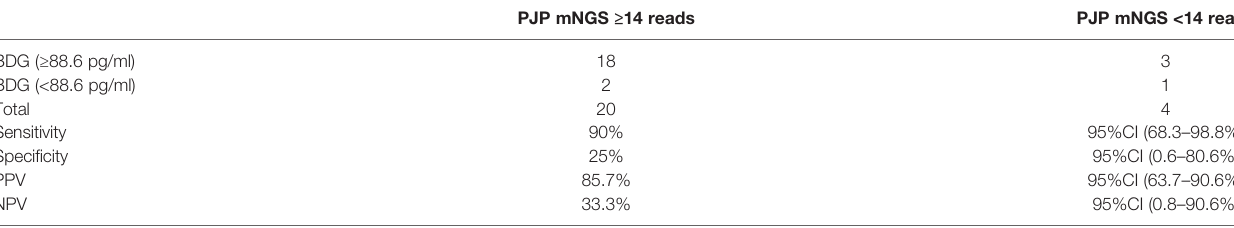
PJP mNGS ≥ 14 reads PJP mNGS <14 reads